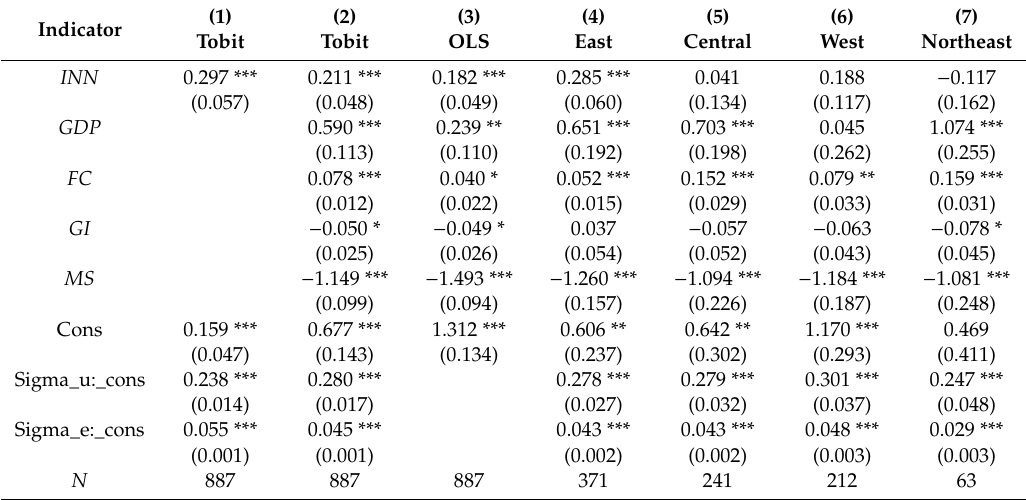
Table 2. Regression results for the direct e ff